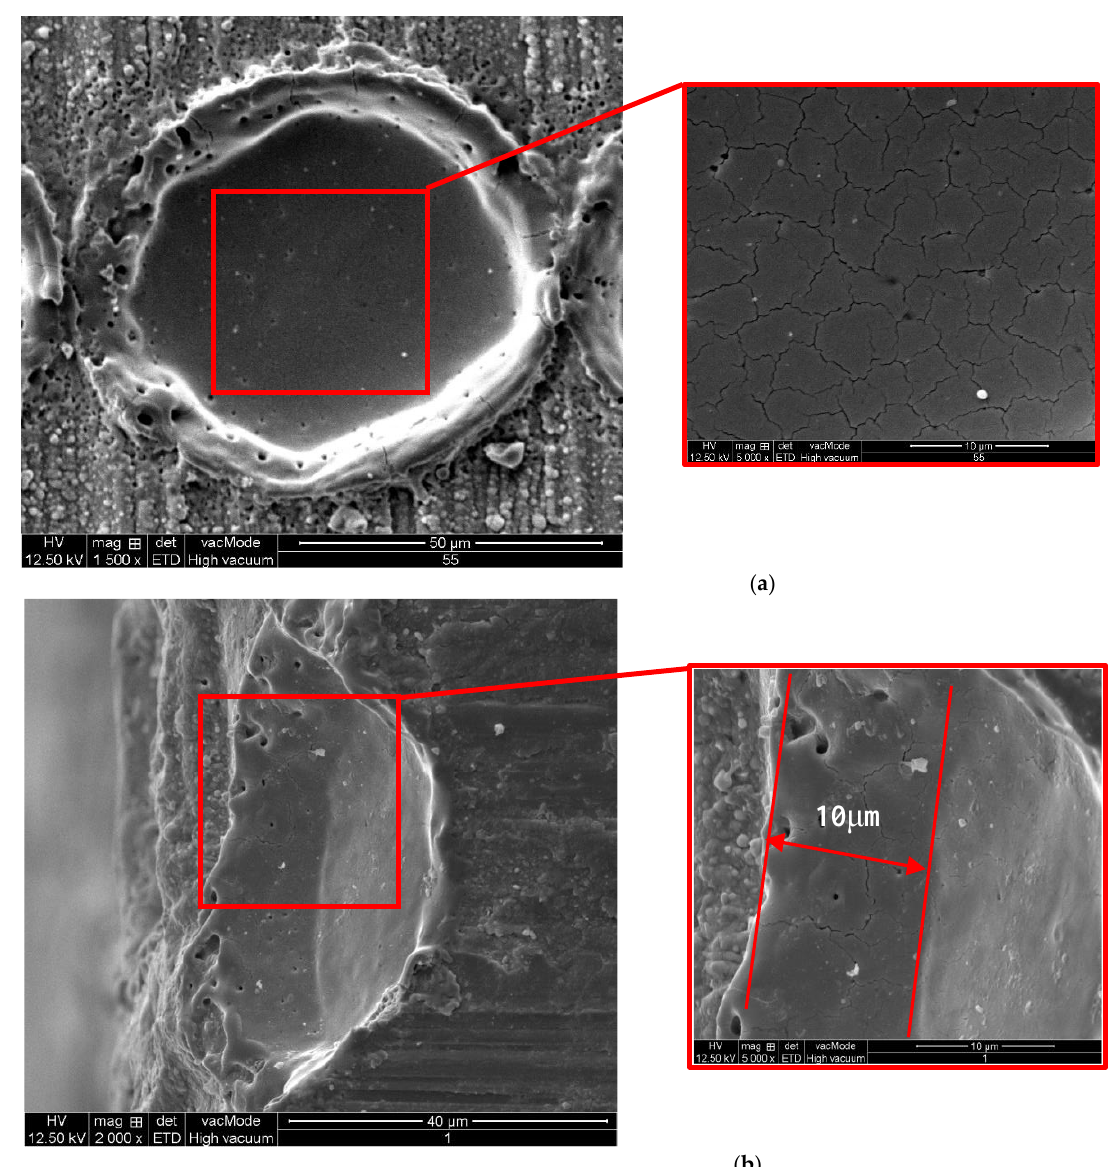
Figure 5. SEM microtopography of a laser pit on zirconia workpiece ( f = 49 kHz, V = 100 mm/min, S 1 = 100 μm, N = 1). ( a ) Top View, ( b ) Section view.